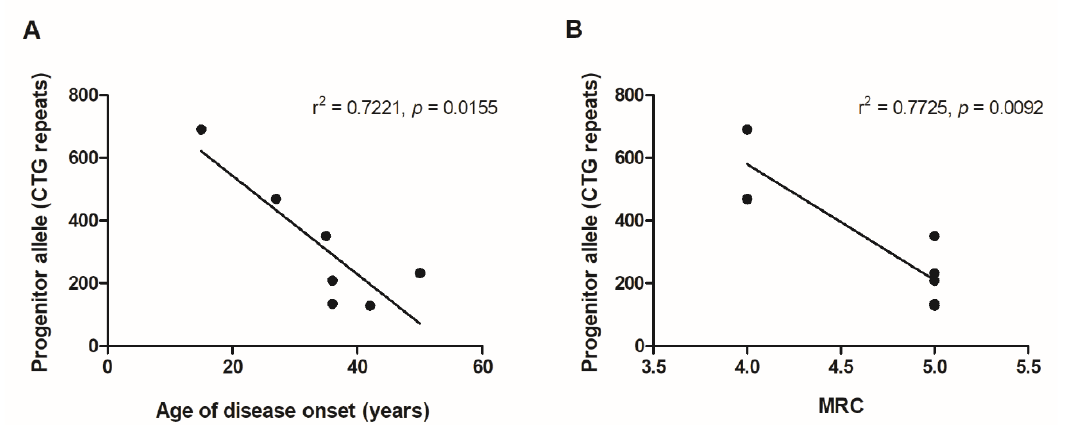
Figure 2. Correlations between the progenitor CTG size present in muscle and the age of disease onset and the MRC of the studied muscles. ( A ) Correlation between the progenitor CTG size present in muscle and the age of disease onset (r = − 0.850 ( − 0.977– − 0.268), p < 0.05). ( B ) Correlation between the progenitor CTG size present in muscle and the MRC of the studied muscles (r = − 0.932 ( − 0.992– − 0.496), p < 0.05).